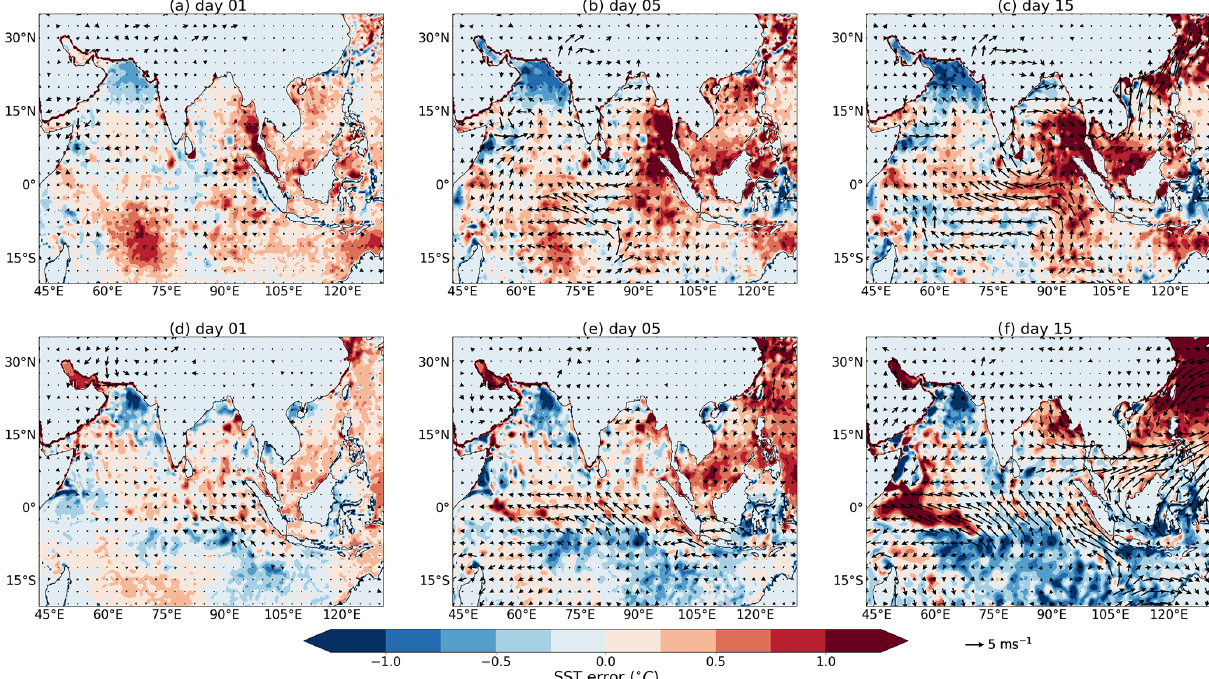
Figure 12. SST error (colours, ◦ C) and 10m wind errors (arrows) from CPLDNWP simulations with respect to OISSTv2 in composites before (10–19 May; top row) and after (10–23 July; bottom row) the broad-scale seasonal transition in 2016, for forecast lead times of 1, 5 and